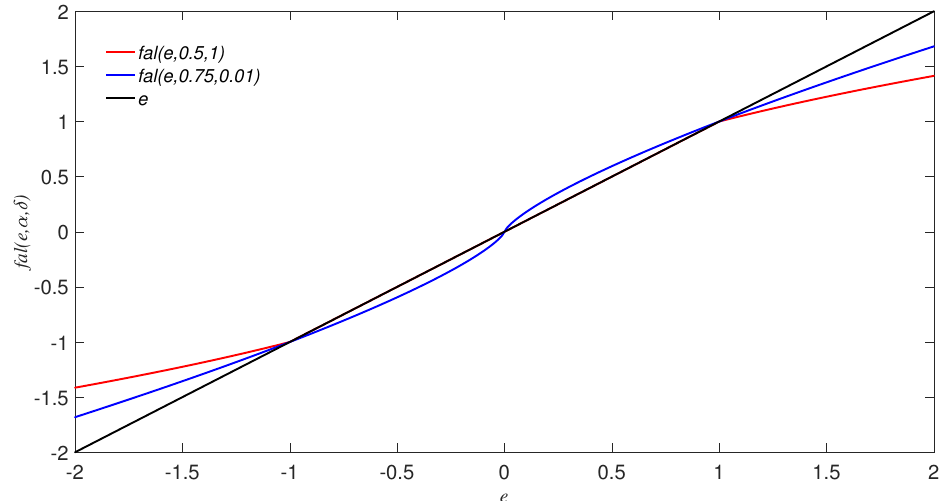
Figure 6. The nonlinear function f al ( e , α , δ ) and the linear function e